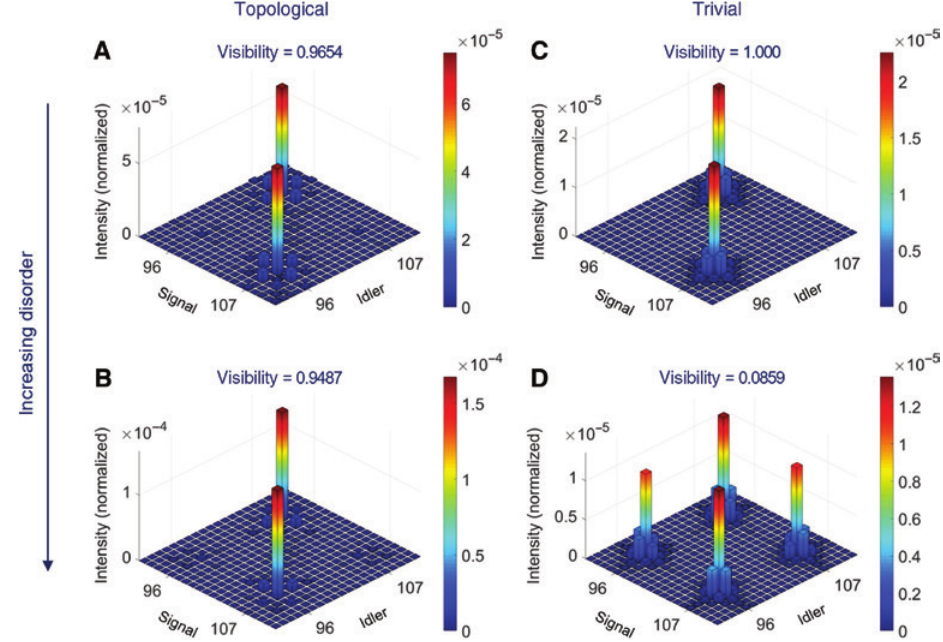
Figure 4: Visibility and biphoton correlation map after interferometry. (A, B) Simulations for fabricated topological lattices from Figure 2A and B, respectively. (C, D) Simulations for fabricated trivial lattices from Figure 3A and B,